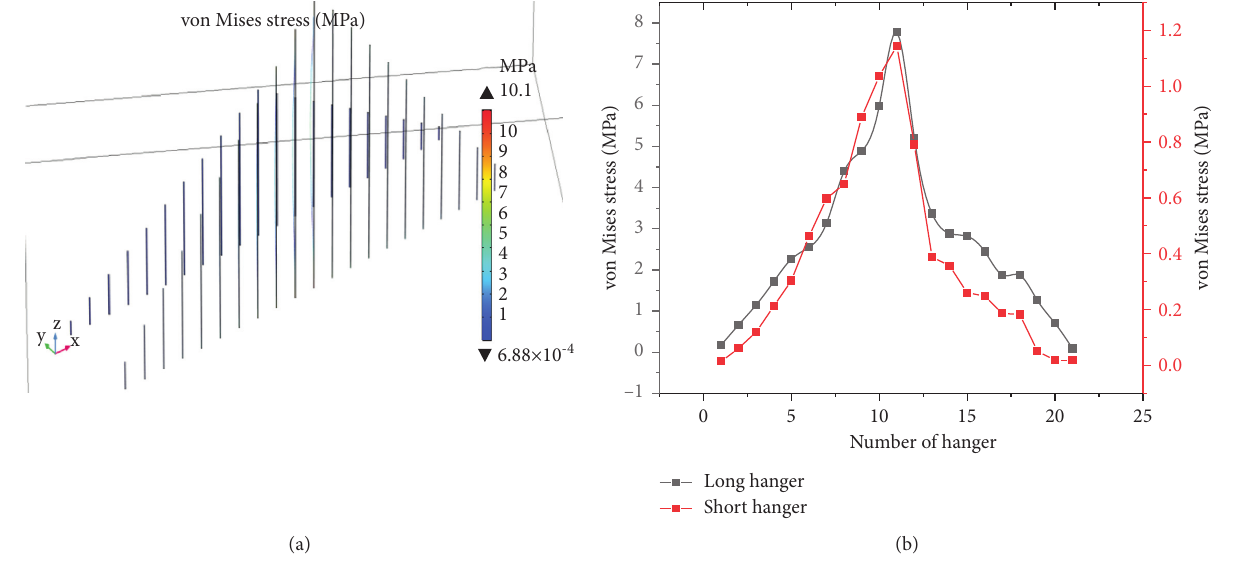
Figure 8: Stress distribution of hangers (wind direction � 60 ° /120 ° ).